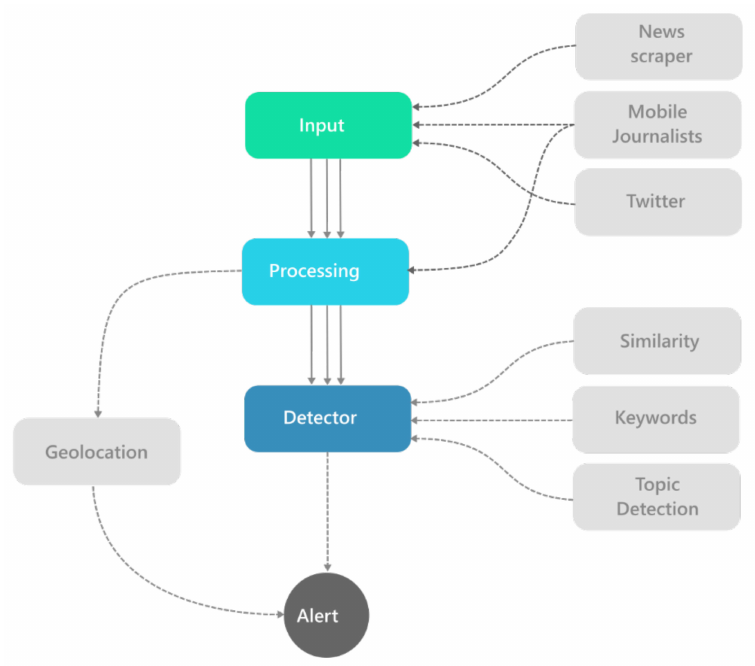
Figure 3. Modularized